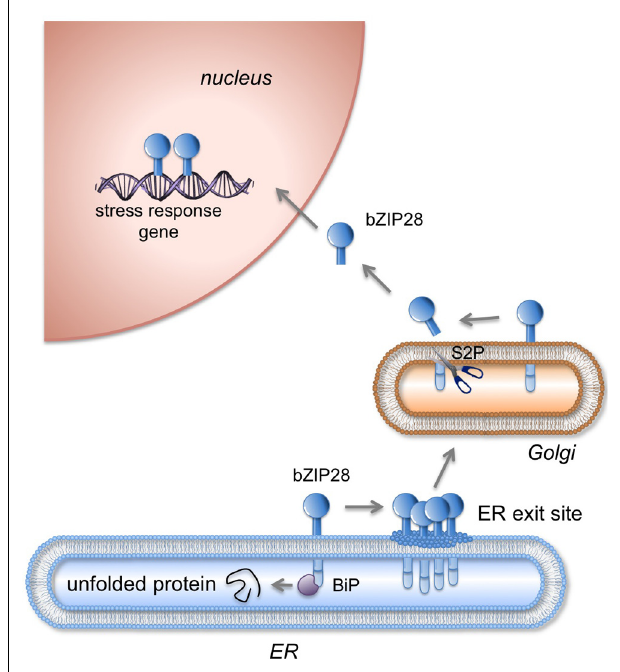
FIGURE 1 | Mobilization of bZIP28 in response to stress. Under unstressed conditions, bZIP28 resides in the ER membrane and is thought to be tethered there by the interaction of its lumenal tail with Binding Protein (BIP). In response to adverse environmental conditions or to an overload in the protein synthesis, unfolded proteins accumulate in the ER and BIP is competed away from its binding to bZIP28. Once freed, bZIP28 interacts with Sar1 GTPase a component of the COPII transport system and transported to the Golgi apparatus. In the Golgi, bZIP28 is processed by resident proteases including Site-2-Protease (S2P) liberating bZIP28’s cytoplasmic domain, which relocates in the nucleus where it upregulates stress response genes. (Figure based on Srivastava etal., 2013).